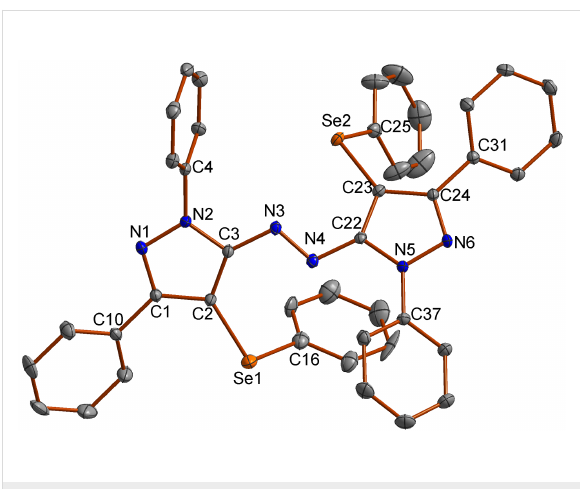
Figure 1: Molecular structure of compound 6 . The hydrogen atoms are omitted for clarity